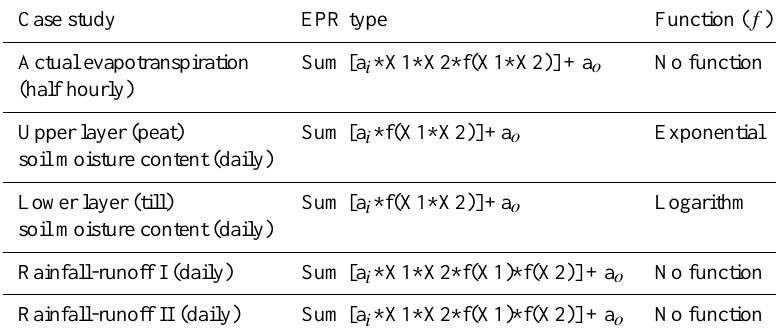
Fig. 5. scatter plots of observed and predicted evapotranspiration. (a) ANNs, (b) GP, (c) EPR, (d) SVM, (e) M5, (f) K-nn, and (g) MLR. Table 5. EPR type and functions of all case